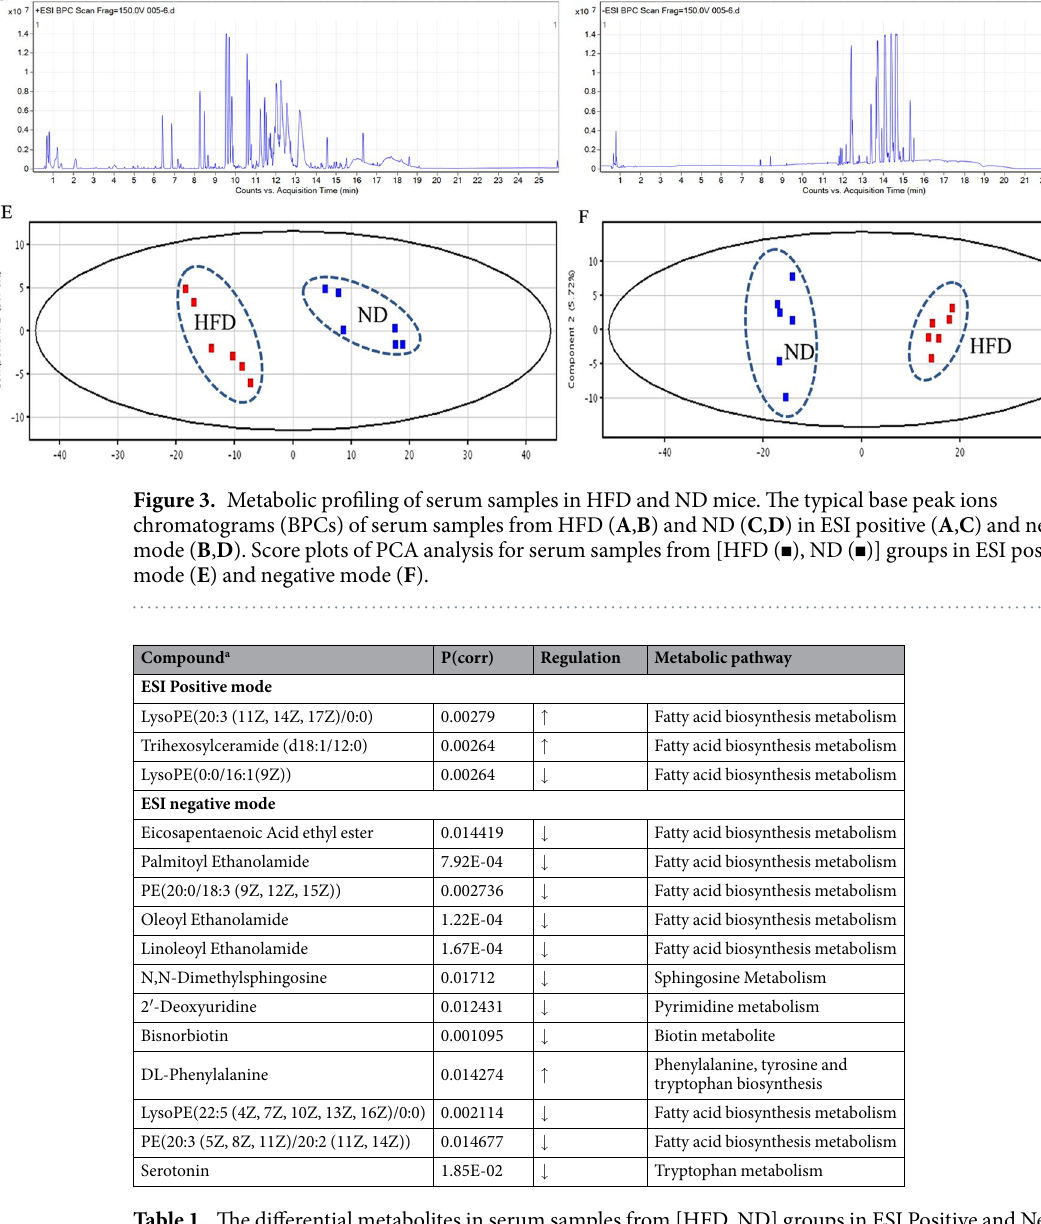
Table 1. The differential metabolites in serum samples from [HFD, ND] groups in ESI Positive and Negative Mode. Statistical significance levels were determined by ANOVA test. Only metabolites with p-values of less than 0.05 were deemed to be statistically